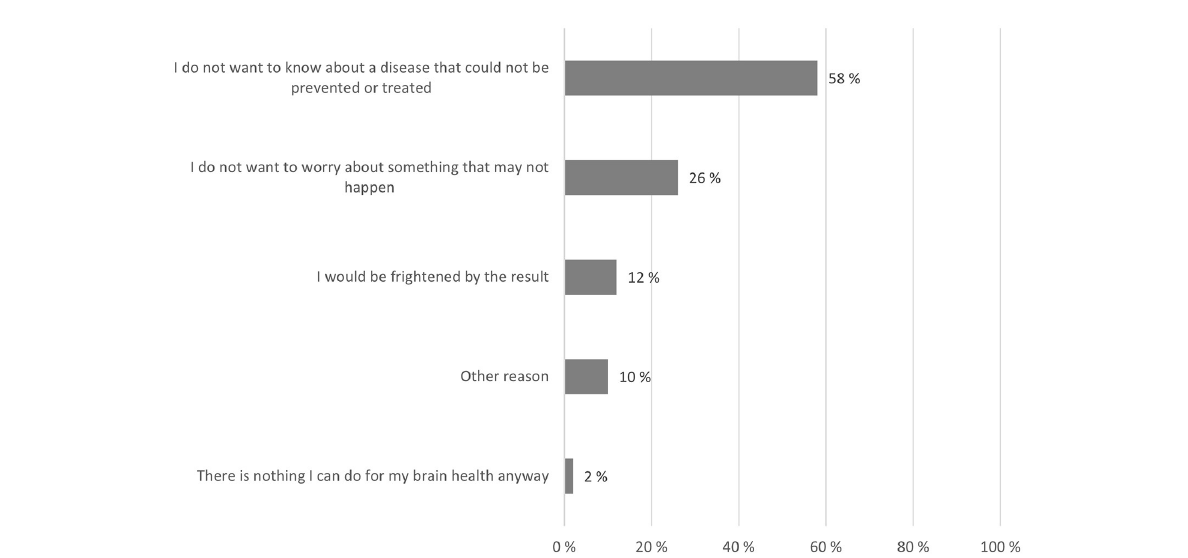
FIGURE3 Reasons for NOT taking a brain health test. Respondents who answered they would not take a test, were asked to select up to two most important reasons for not doing so. Numbers indicate the percentage of respondents who chose each reason (percentages exceed 100% in total because respondents could choose up to two